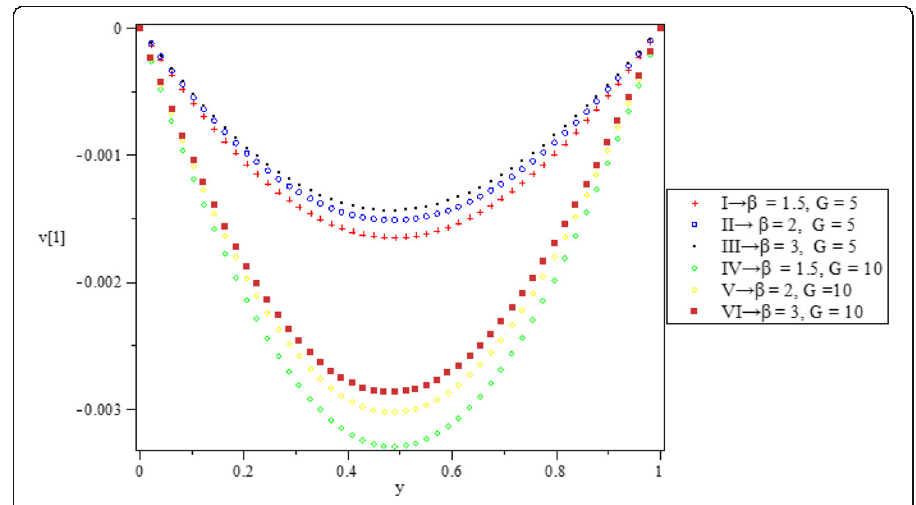
Fig. 25 First-order velocity (v[1] profile, r = − 1, ϵ = 0.25, P = 0.71 α = 5, and λ = 0.01)